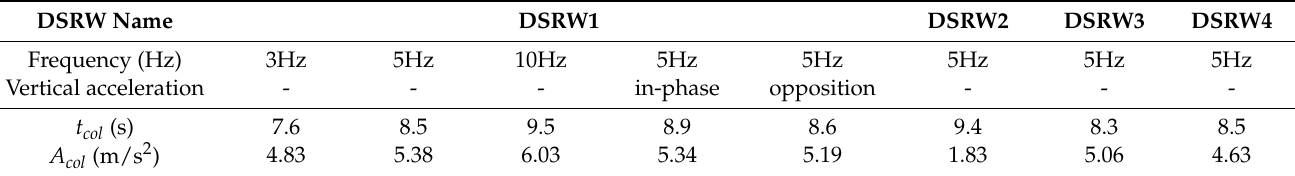
Figure 15. Comparison of the response of DSRW1 subjected to dynamic input signals with and without vertical acceleration. Table 7. Collapse acceleration A col and time t col for all simulations performed. Here, t col is almost constant for all the simulations (with a range between 7.6 s and 9.5 s, and a coefficient of variation of